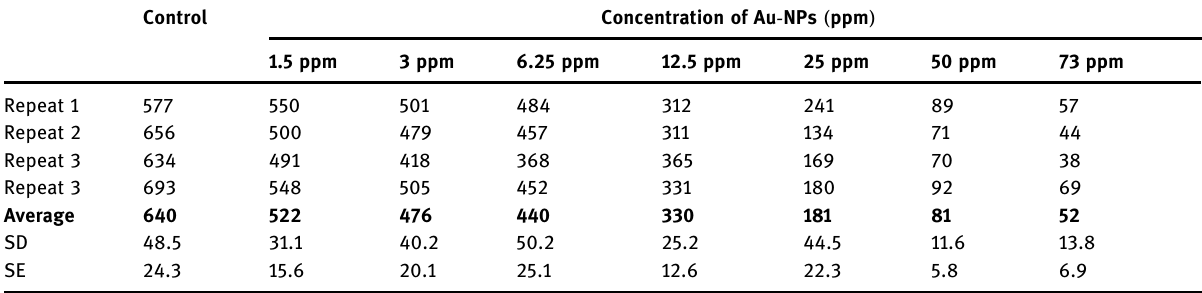
Table A1: The inhibition of cell growth assays of C. Hinds ii - AuNPs on HeLa